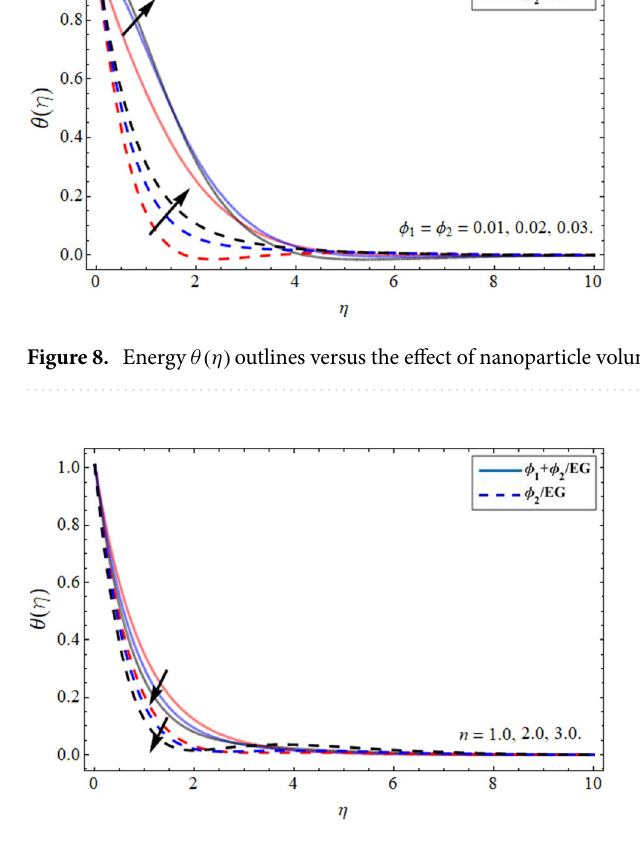
Figure 9. Energy θ(η) outlines versus the effect of parameter n .